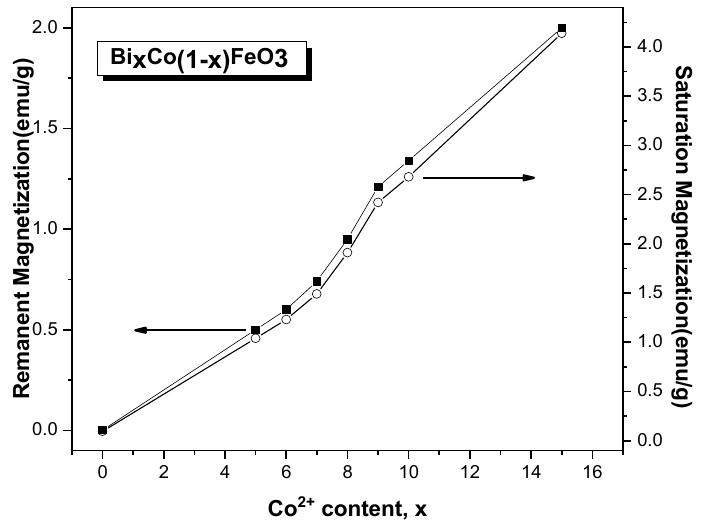
Figure 7. Variation in the magnetic parameters with Co 2 + content, x, for Bi ( 1 − x ) Co x FeO 3 , thermally treated at 700 °C for 30 min. Table 1. Magnetic parameters for the pure and 15% Co-doped BFO powders thermally treated at 700 °C for 30 min.